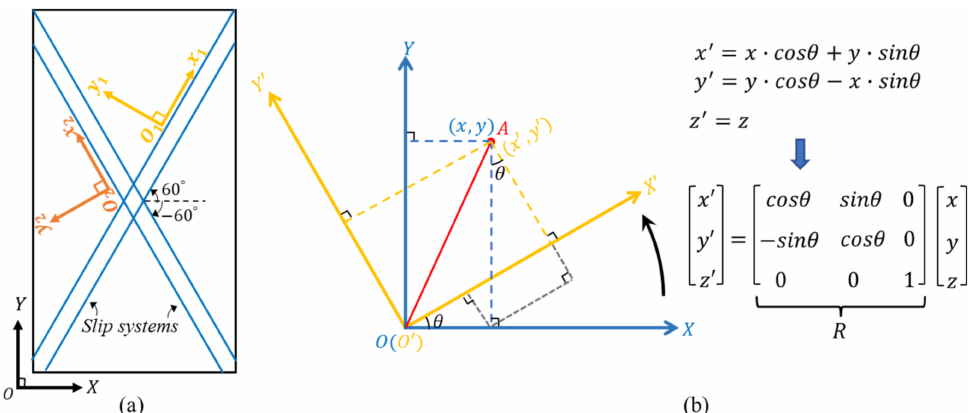
Figure 4. Schematic of two-dimensional coordinate system conversion. ( a ) ( x , y ) and ( x (cid:48) , y (cid:48) ) represent the position of point A in the coordinate system OXY and O (cid:48) X (cid:48) Y (cid:48) , respectively. ( b ) The transformation matrix R can be obtained from the relationship of two coordinate